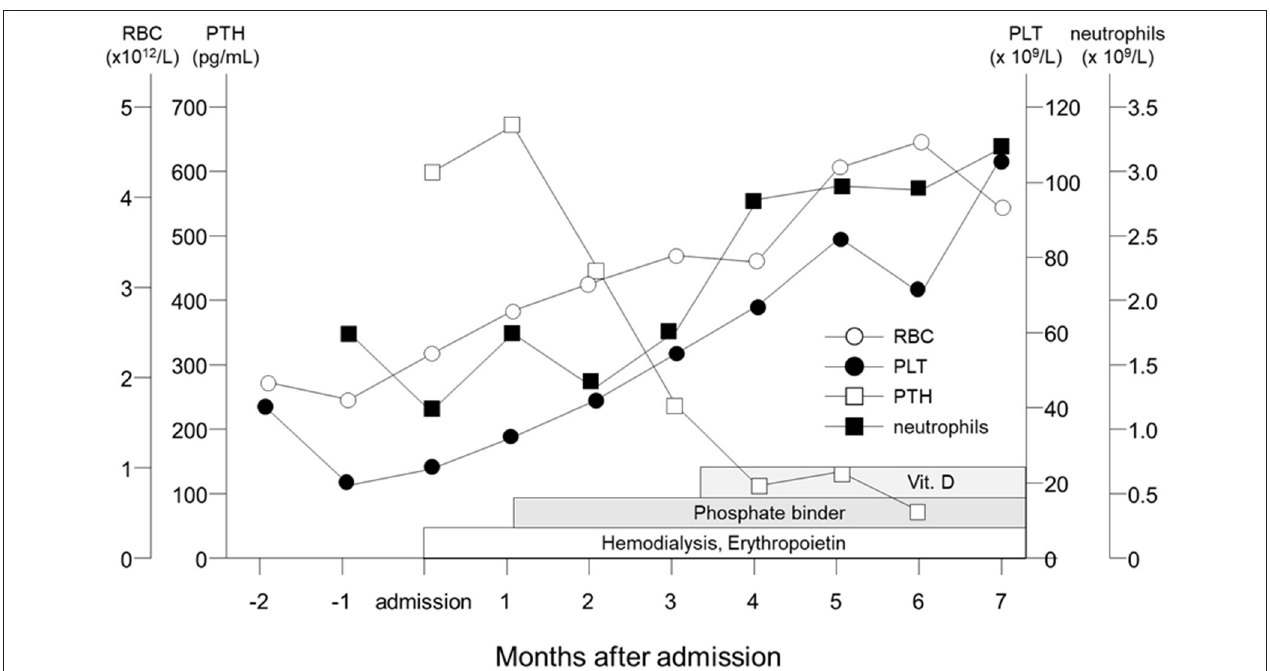
FIGURE 3 | Clinical course of the patient. Parathyroid hormone levels (open square) are shown to fall and neutrophils (filled square), erythrocyte counts (open circle) and platelets (filled circle) are shown to rise gradually following HD and pharmacological therapy with Epo, phosphate binder and active vitamin D.